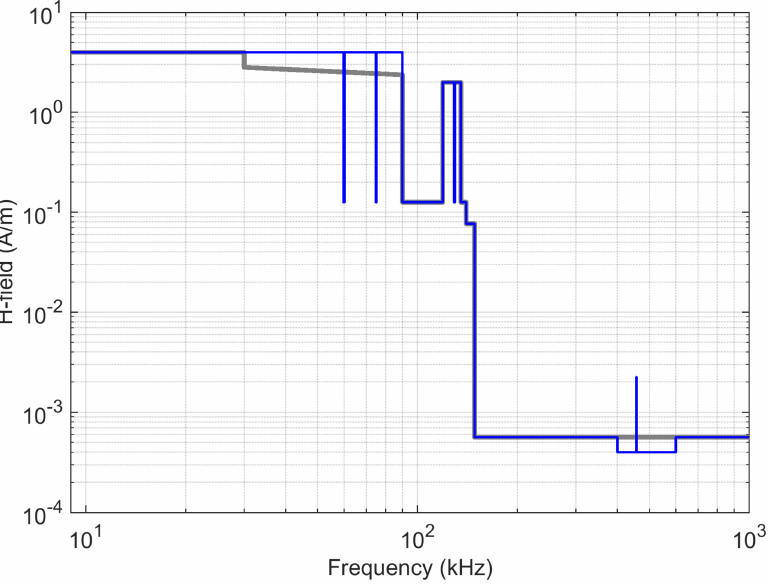
Figure 1. Short-Range Devices (SRDs) of the inductive type, excluding wireless power charging and telemetry for implantable devices as per EN 300 330 [29] (thick grey) and EU Decision [30] (blue): H-field limits are extrapolated to 1 m from the given 10 m values by adding 60 dB, as per Annex H of the EN 300